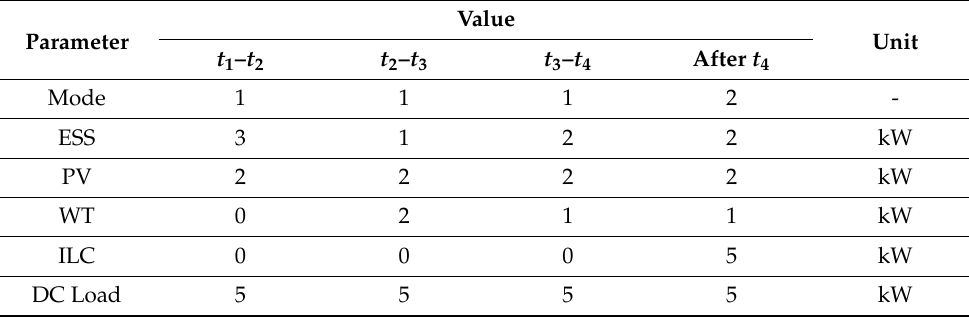
Table 3. Microgrid power flow (2) in grid-connected operation.